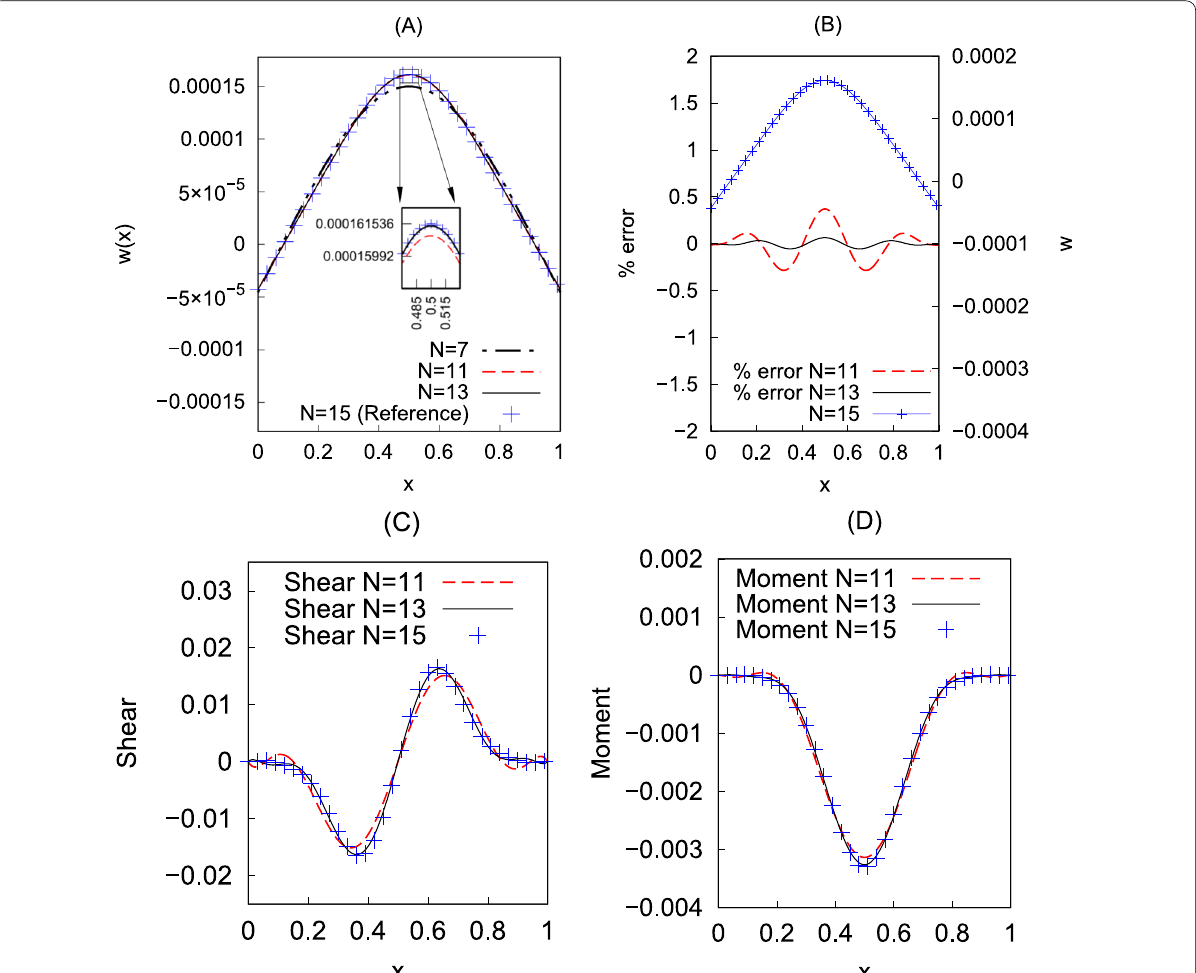
Fig. 14 Case (5) RRM and exact results. A Exact solution and RRM solutions. B Exact deflection and percentage error for various orders. C Exact and RRM shear. D Exact and RRM moment